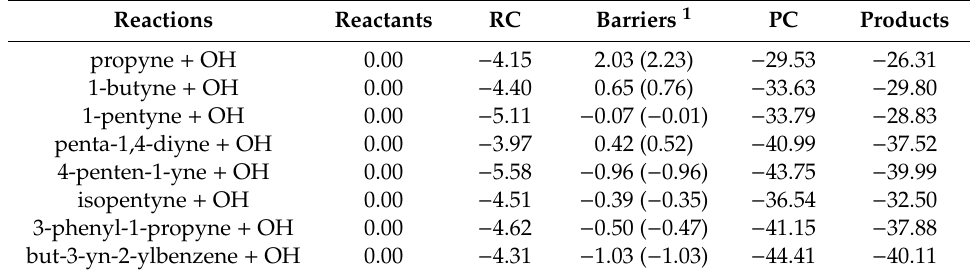
Table 3. Potential energies for the studied alkynes with OH at M08-HX / cc-pVTZ level (kcal mol − 1 ). All the energies are relative to the